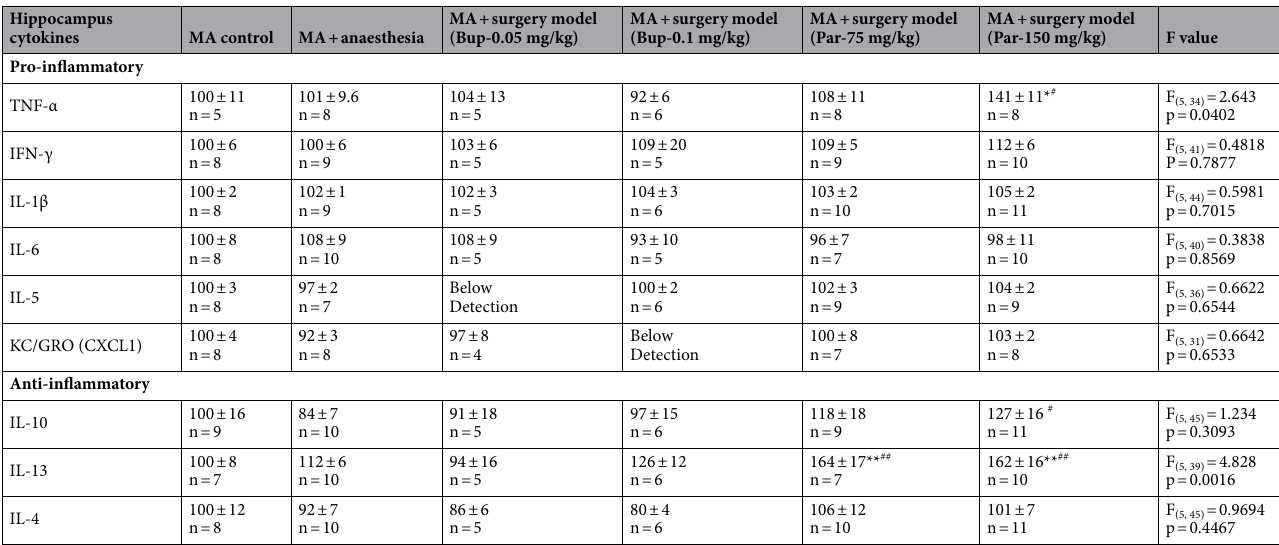
Table 2. Analysis of cytokine levels in hippocampal tissue. Data are expressed as percentage of MA Control group ± SEM, n = 5–11 per group. One-way ANOVA followed by Fisher’s LSD analysis **p < 0.01, *p < 0.05